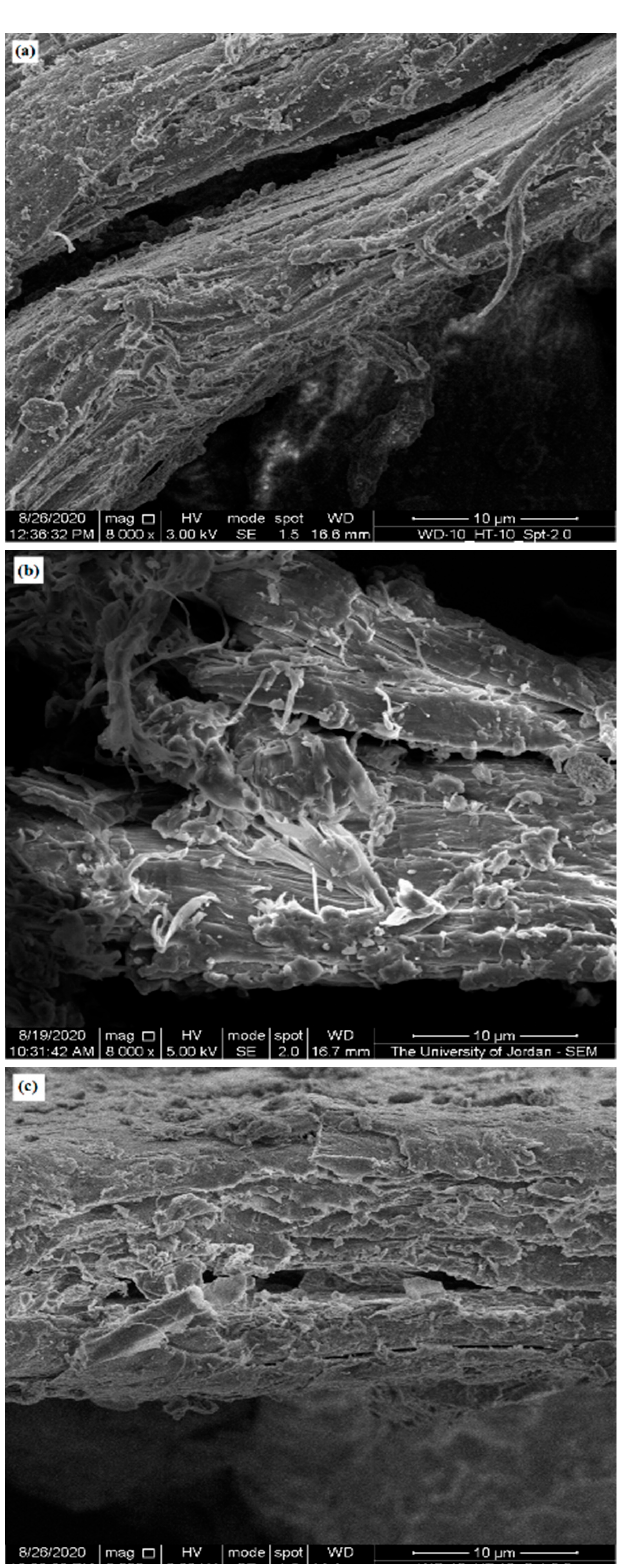
Figure 3. SEM image of ( a ) crab (CH-Cr), ( b ) shrimp (CH-Sh), and ( c ) squid (CH-Sq) CHs at 8000× magnification .